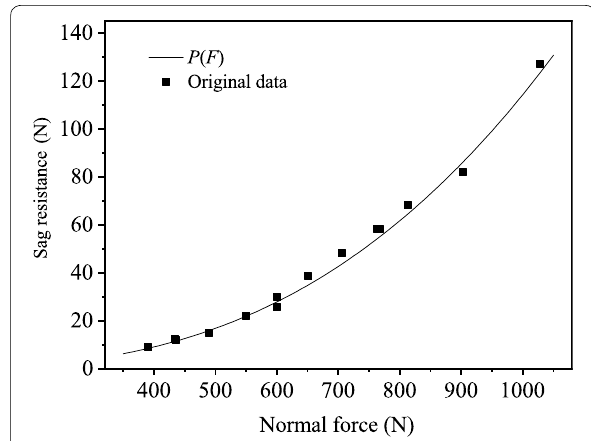
Figure 11 Relationship between the normal force and the sag